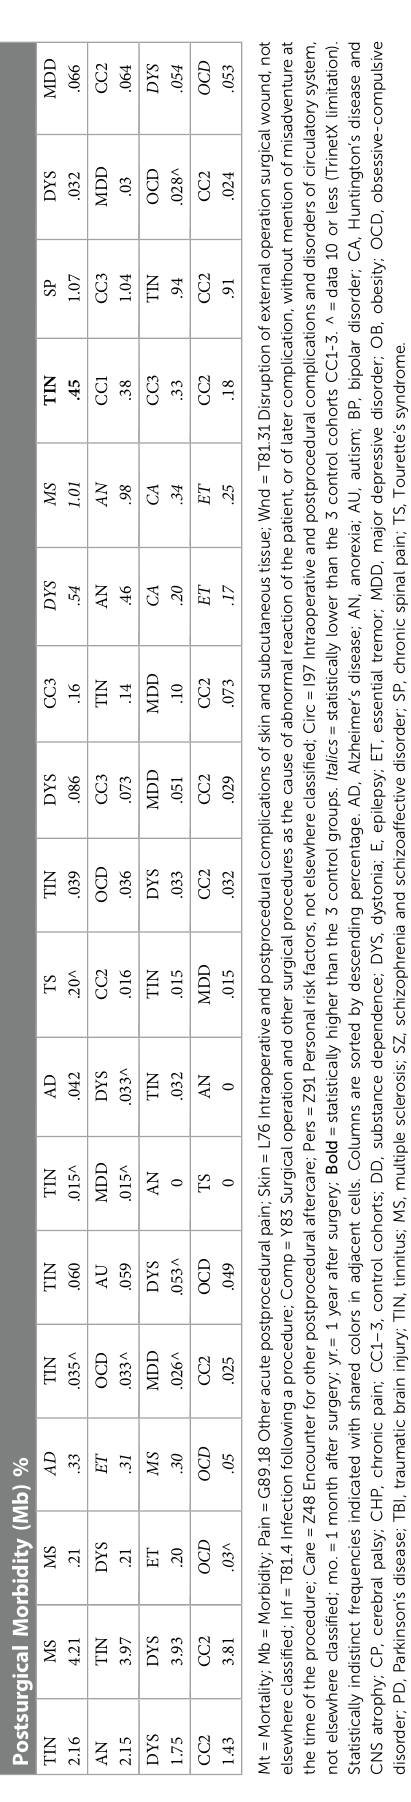
Table 9 ). At one year after surgery, the AD (10.12%) and